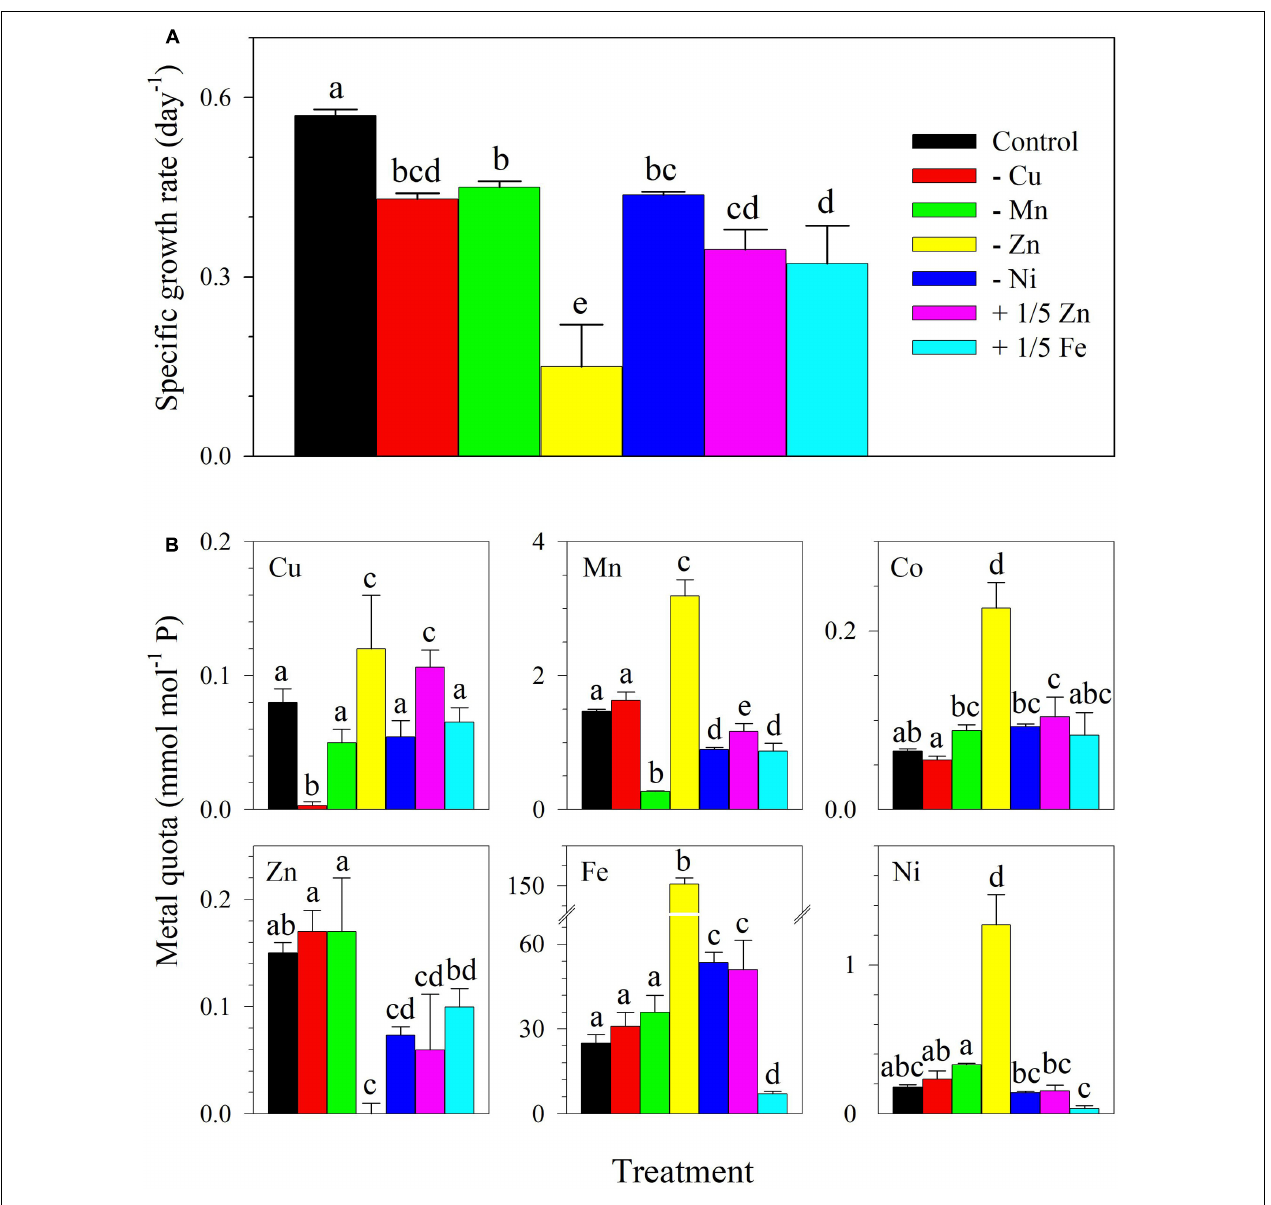
FIGURE 3 | (A) Specific growth rates and (B) trace metal quotas of S. kawagutii subjected to different trace metal availability. The control treatment was grown with 1.25 nM Fe (cid:48) , 12.5 pM Zn (cid:48) , 0.50 pM Cu (cid:48) , 4.2 nM Mn (cid:48) , 20 pM Co (cid:48) , and 6.7 pM Ni (cid:48) . The values represent means ± SD ( N = 3, P < 0.05, ANOVA, post hoc Tukey